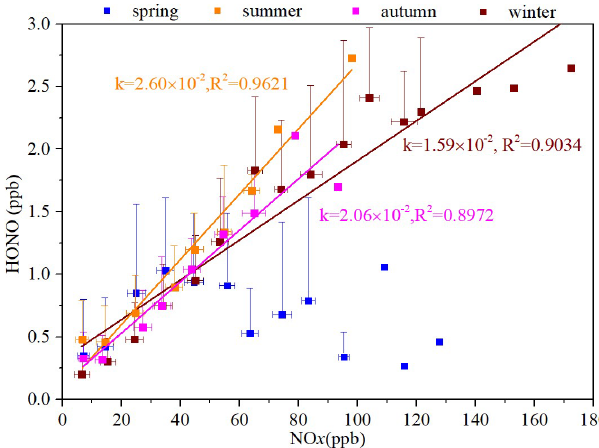
Figure 10. The ratio of HONO / NO x in the four seasons (correla- tion between the average of NO x per 10ppb interval and the average value of